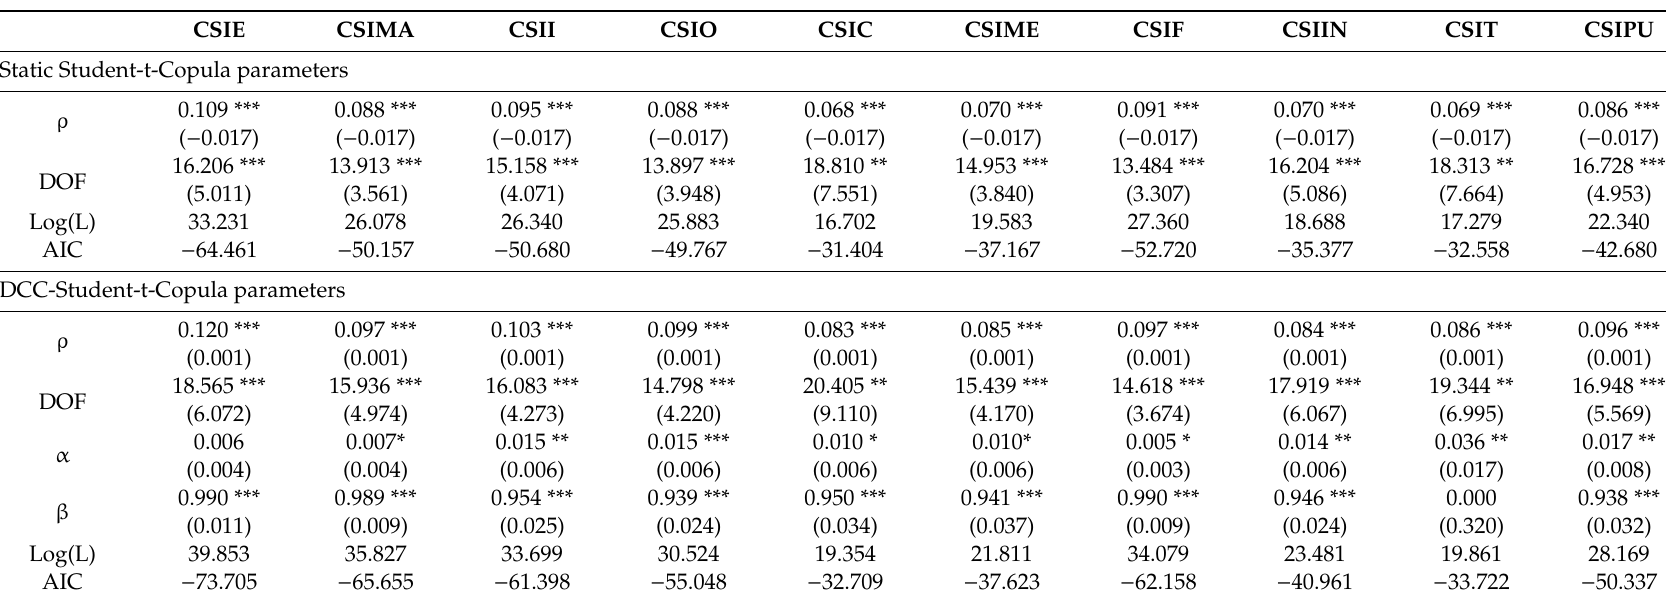
Table A5. Estimates of T-Copula for original returns series between WTI spot price and the stock indexes of China Securities